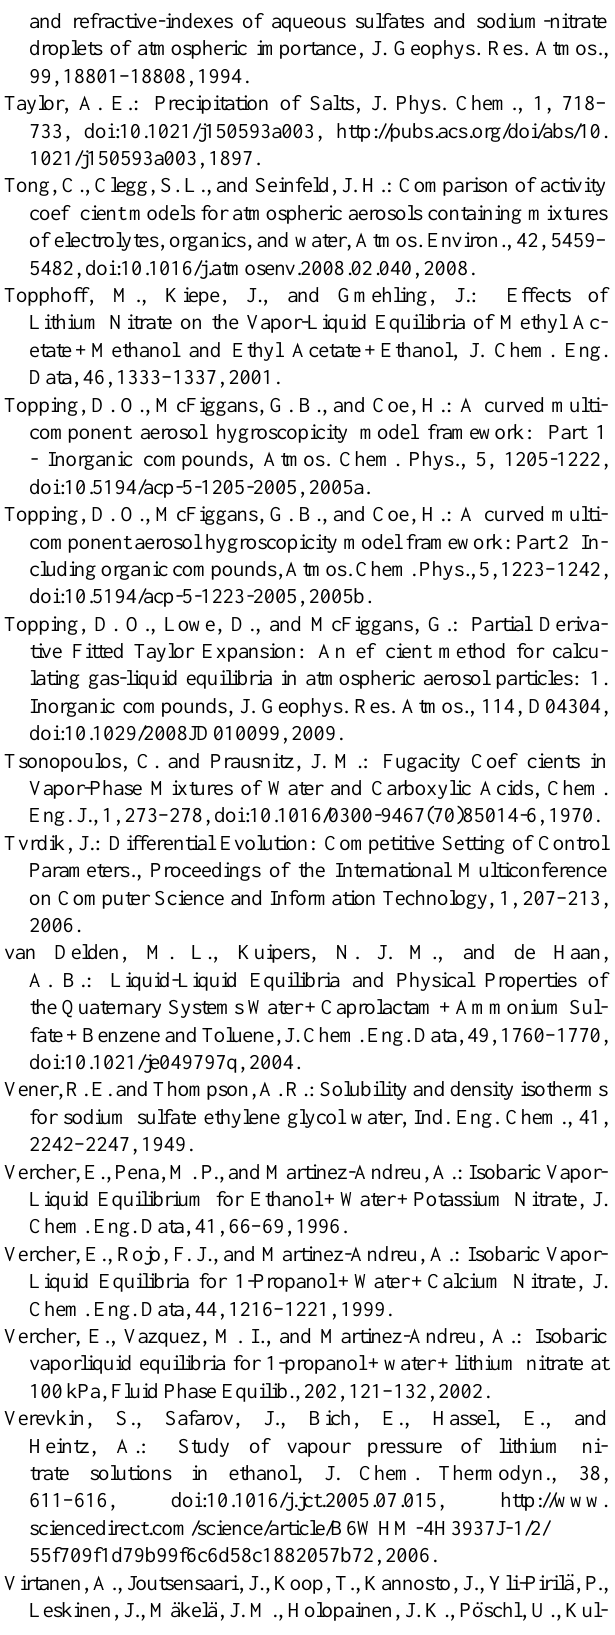
Taboada, M. E.: Liquid-liquid and solid-liquid equilibrium